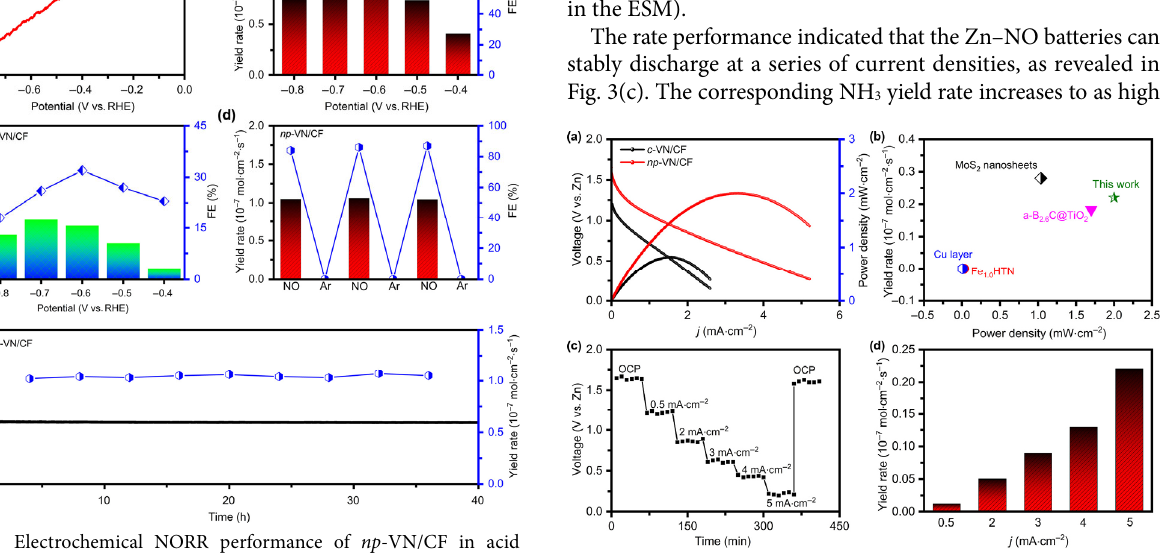
Figure 3 Zn–NO battery performance. (a) Discharge polarization curves and power density curves. (b) Comparison of NH 3 yield rate and power density. (c) Voltages at different discharging current densities per 1 h and (d) the corresponding NH 3 yield